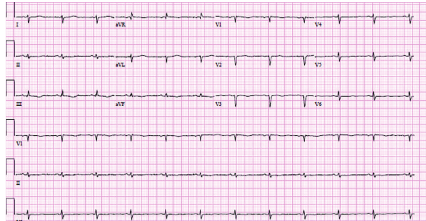
Figure 2: EKG. Low voltage QRS complexes.